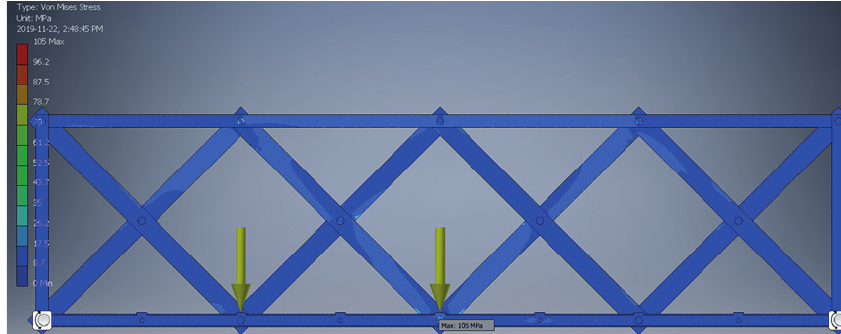
Figure 14. The simulation result of DWT model